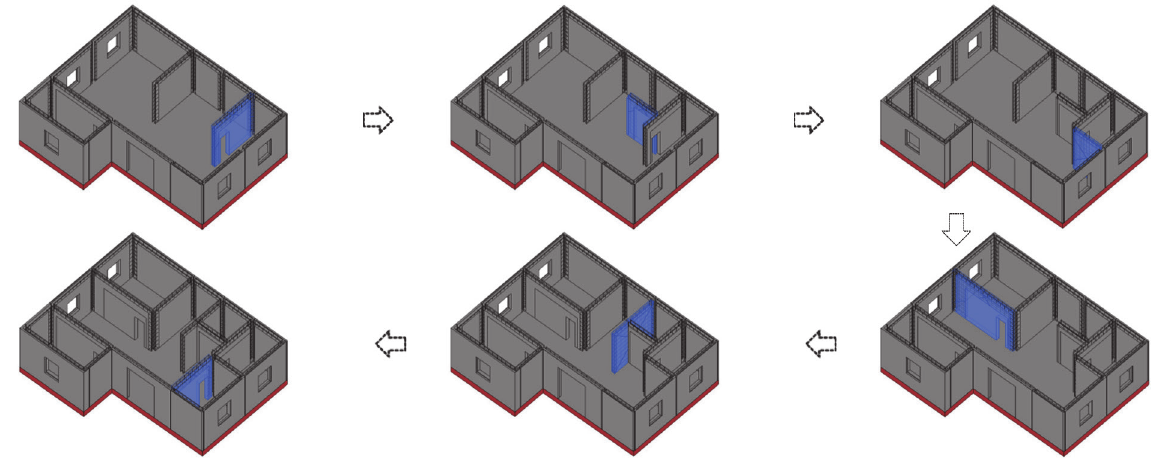
Figure 10. BIM-based visual simulation in construction